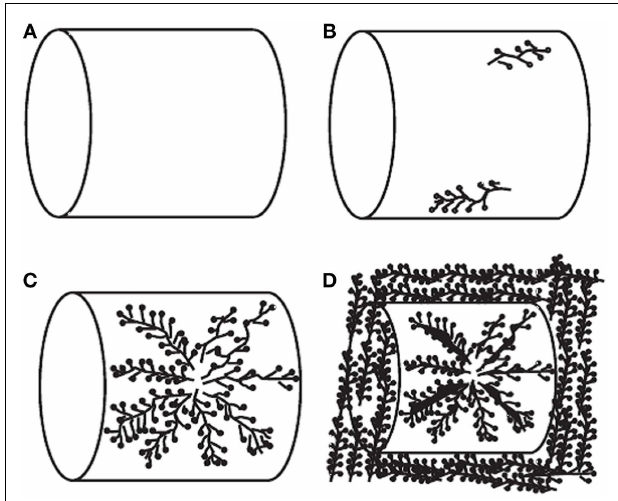
FIGURE 8 | Schematic diagram of PEI loaded in the mesoporous molecular sieve of MCM-41 . (A) MCM-41 support; (B) low PEI loading; (C) high PEI loading; (D) extremely high PEI loading, reproduced from Ma et al.